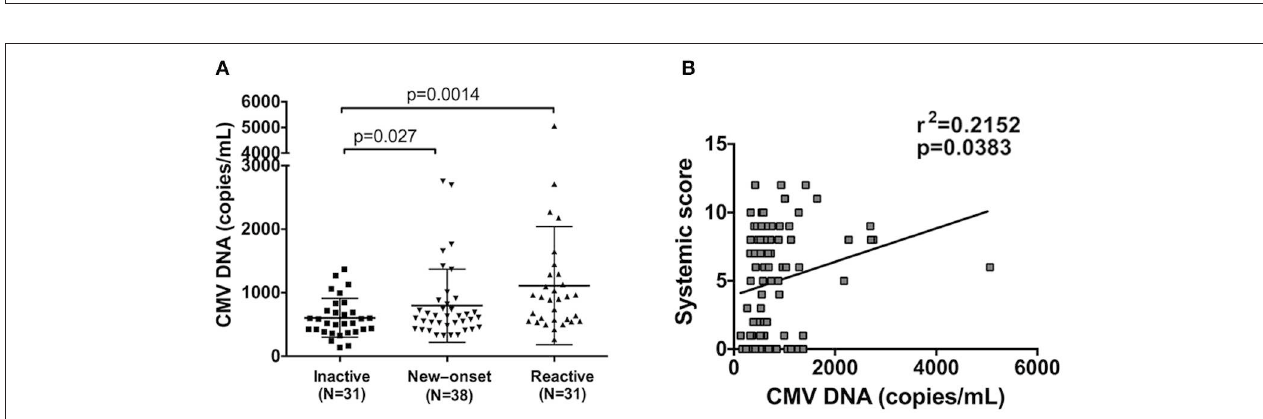
FIGURE 3 | Comparison of the anti-CMV antibody levels in AOSD patients with different clinical manifestations. The levels of anti-CMV IgM and IgG antibody in AOSD patients with or without fever (A,B) , rash (C,D) , sore throat (E,F) , and arthralgia (G,H) . The data represent the mean ± SD by Student’s t -test.